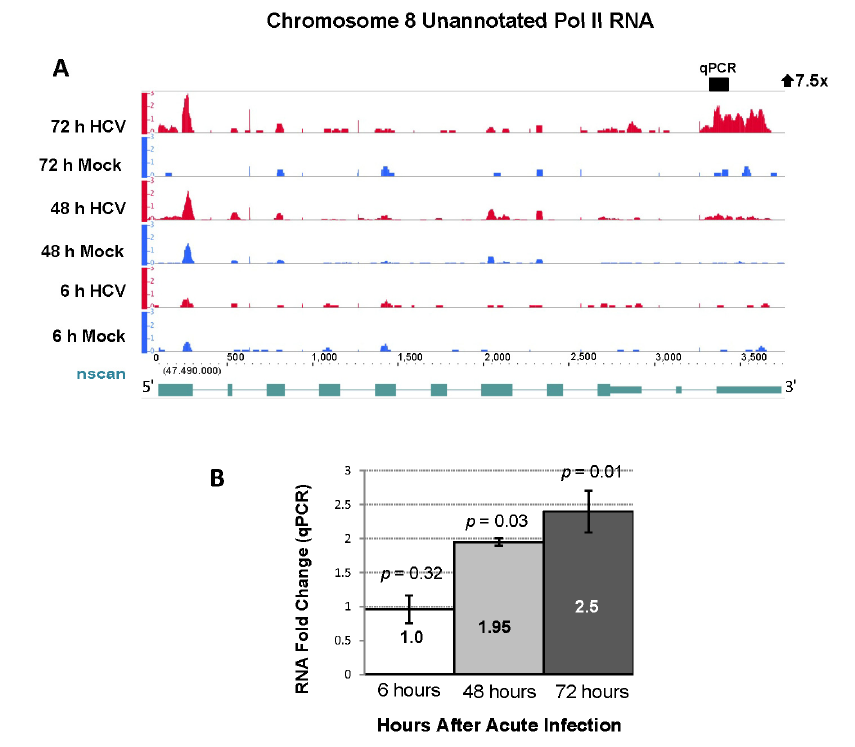
Figure 8. Differential expression of a novel Pol II transcript during acute HCV